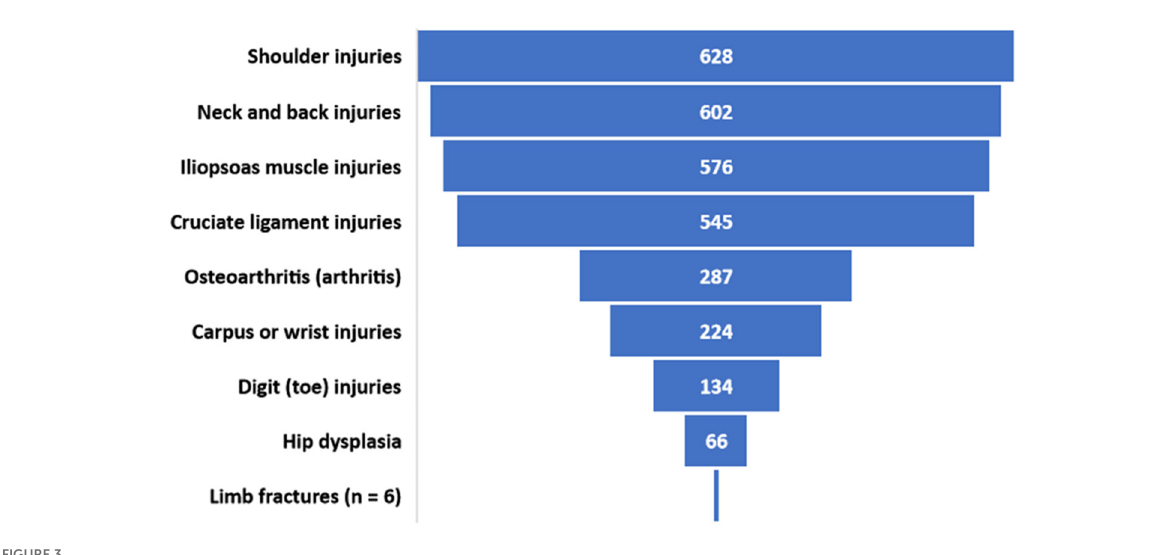
FrontiersinVeterinaryScience